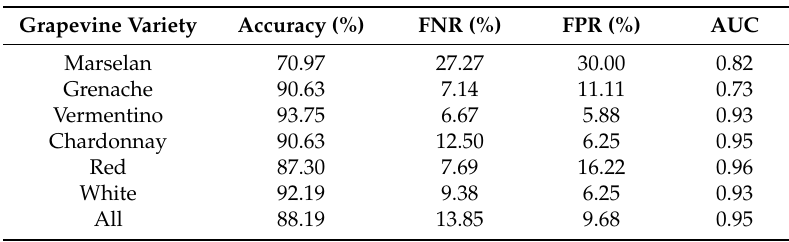
Table 3. Results of using complete spectra in classifying different groups of spectral data acquired in the August acquisition campaign (Severity of infestation = 1).